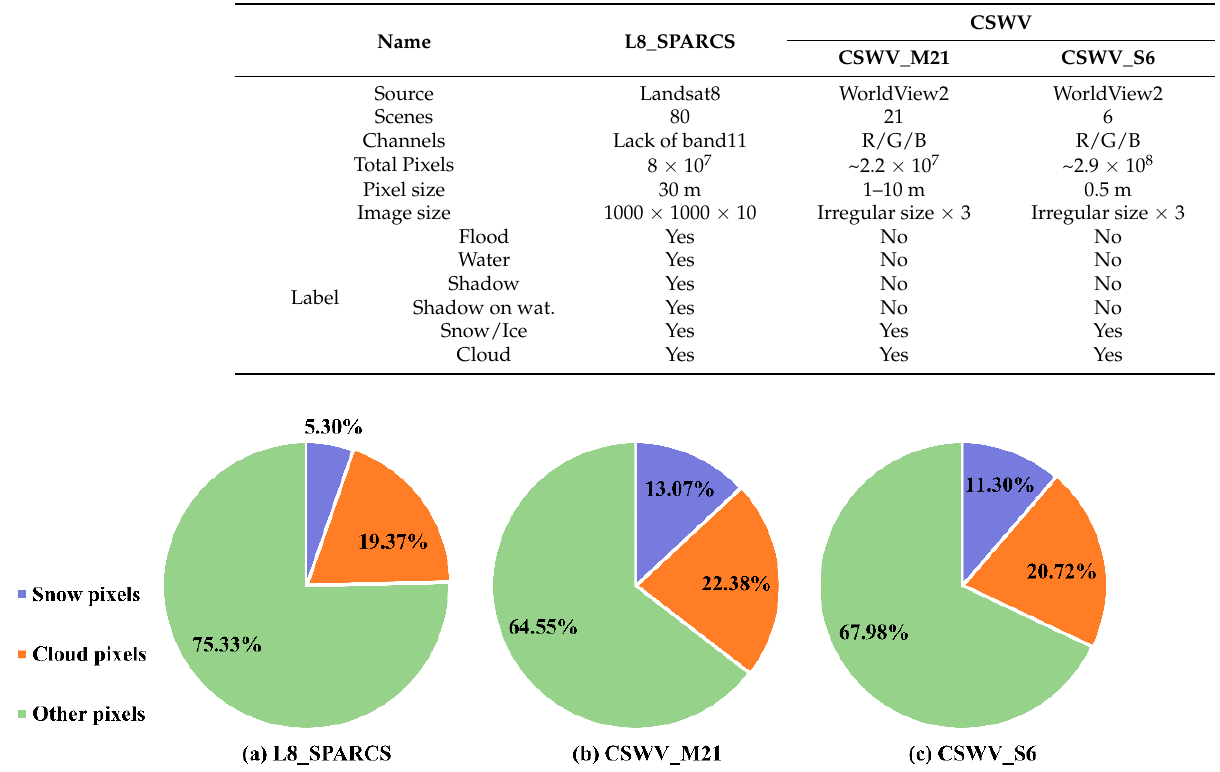
Table 1. The detailed information of L8_SPARCS, CSWV_M21, and CSWV_S6 datasets.